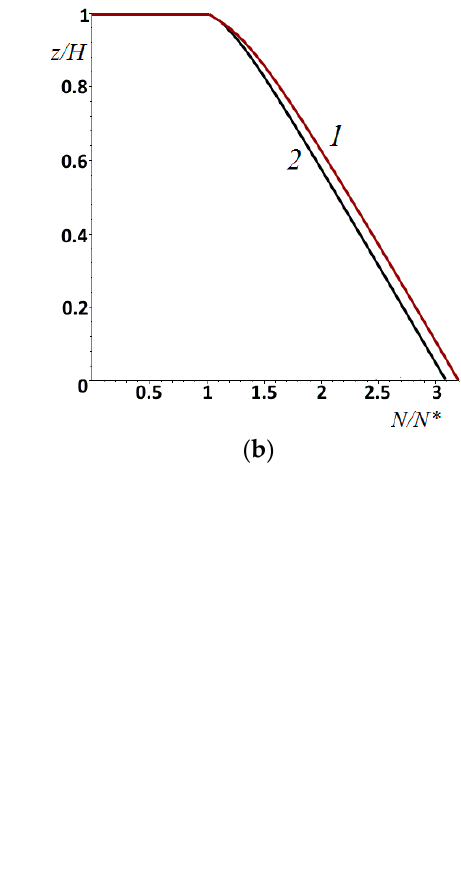
Figure 6. Distribution of the damage function within the layer at different phases of fatigue: μ= 0